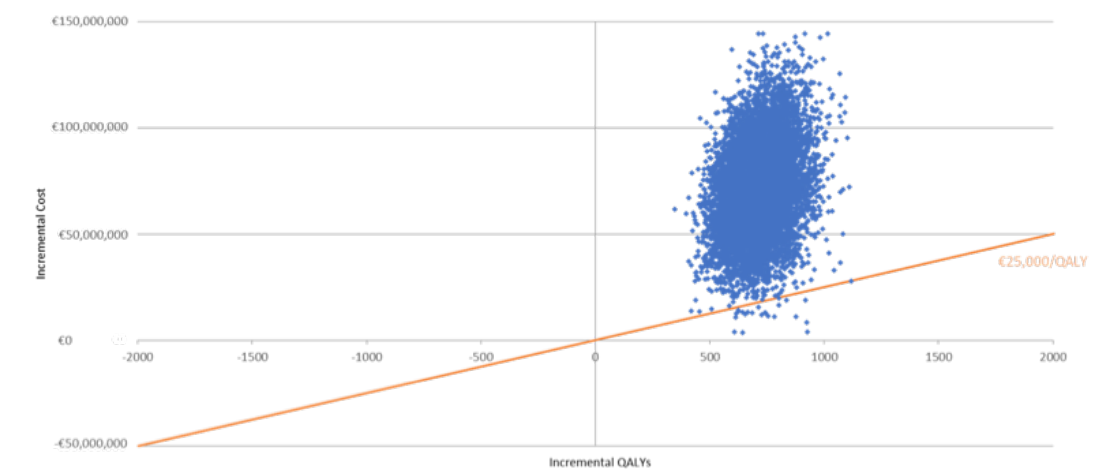
Figure 3. Cost-effectiveness plane for QIVr vs. aQIV in the probabilistic sensitivity analysis